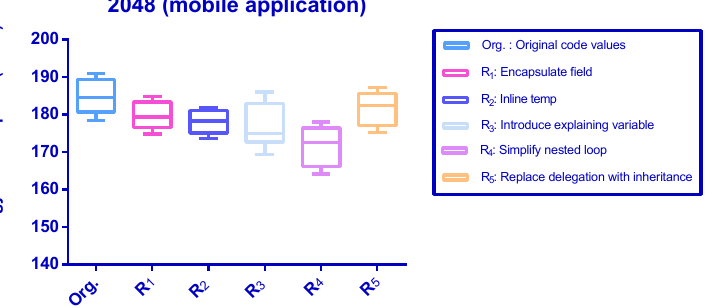
Figure 4. Boxplot of energy consumption results of the original and refactored codes for the mo- bile phone dataset. The x axis represents the name of each dataset and the y axis represents the energy